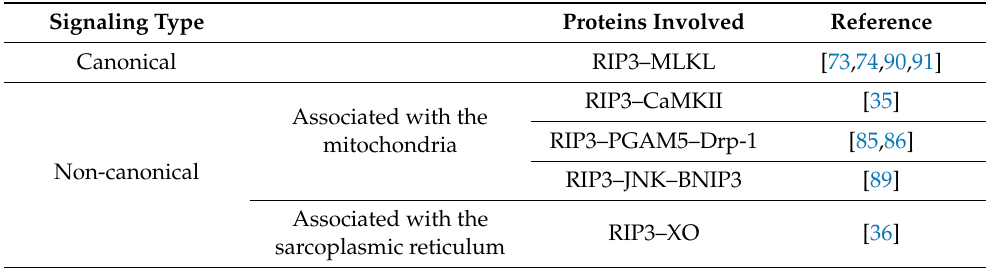
Table 1. The proposed canonical and non-canonical signaling pathways of